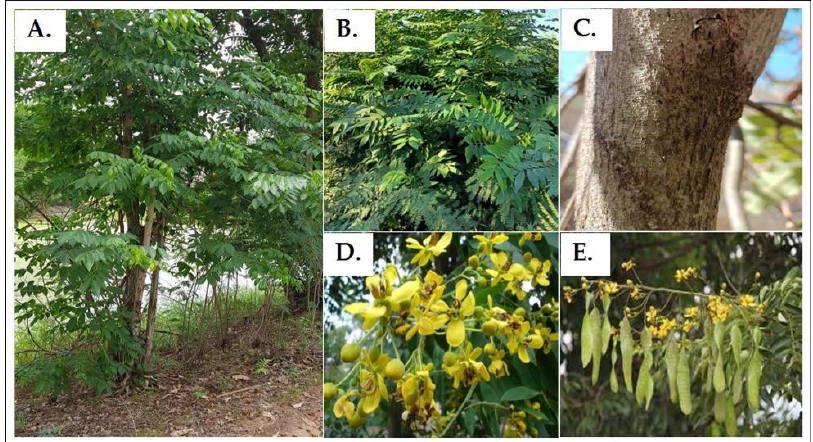
Figure 1. S. garrettiana in the natural ecosystem: ( A ) the suppression zone of S. garrettiana that reduces the growth of other plant species under the canopy, ( B ) leaves, ( C ) trunks, ( D ) flowers, and ( E ) pods of S. garrettiana .